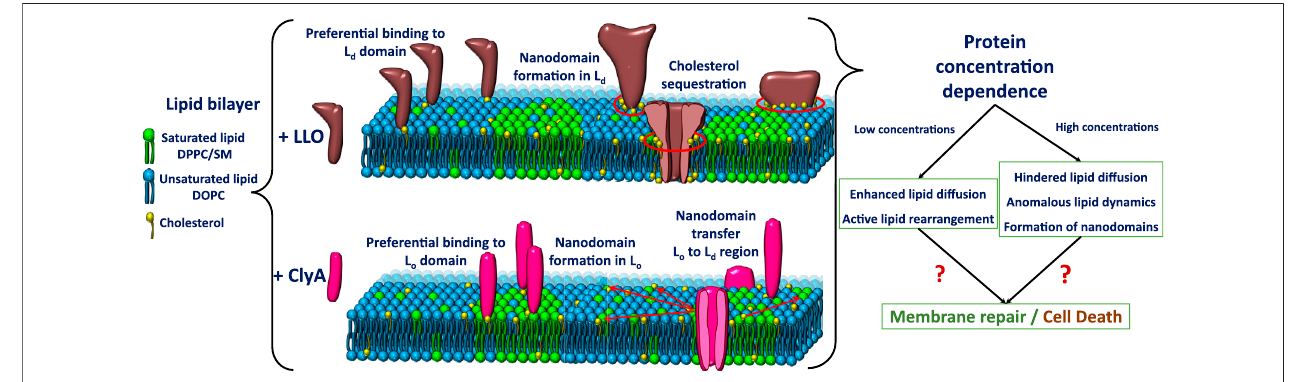
FIGURE14| Schematicrepresentationofthephaseseparatedliquidordered(L o )andliquiddisordered(L d )phasesonlipidbilayermembranes andthepreferential binding and assembly pathways of LLO and ClyA to these